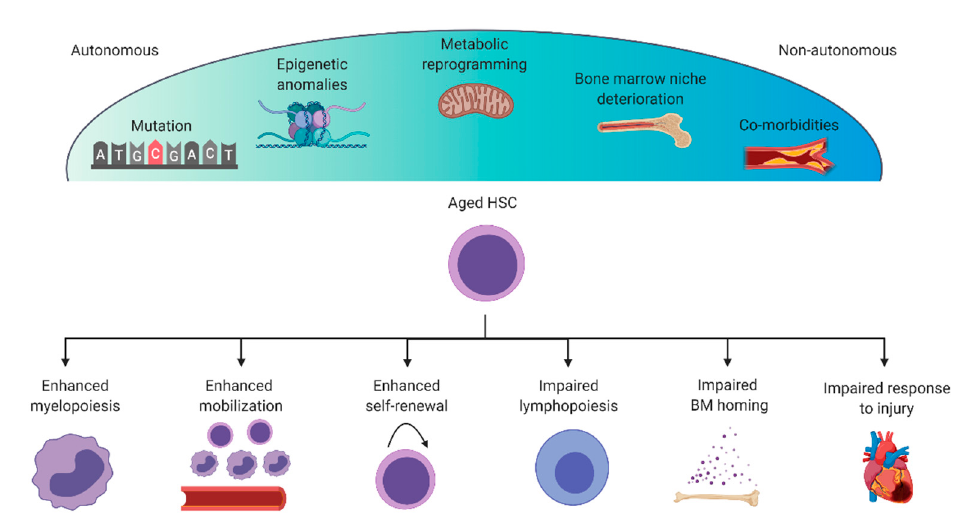
Figure 2. Mechanisms and consequences of immune cell aging. Cell intrinsic (autonomous) mechanisms of immune cell aging include mutations, epigenetic anomalies and metabolic reprogramming. Cell extrinsic factors that influence immune cell aging include deterioration of the bone marrow niche and co-morbidities, such as coronary artery disease or diabetes. With time, HSCs encounter various autonomous and non-autonomous drivers of aging that have downstream consequences on cell phenotype and systemic tissue function. Aged HSCs undergo enhanced myelopoiesis (myeloid skewing), mobilization to the circulation and self-renewal and show deficiencies in lymphopoiesis, BM homing and their ability to respond appropriately to tissue damage.